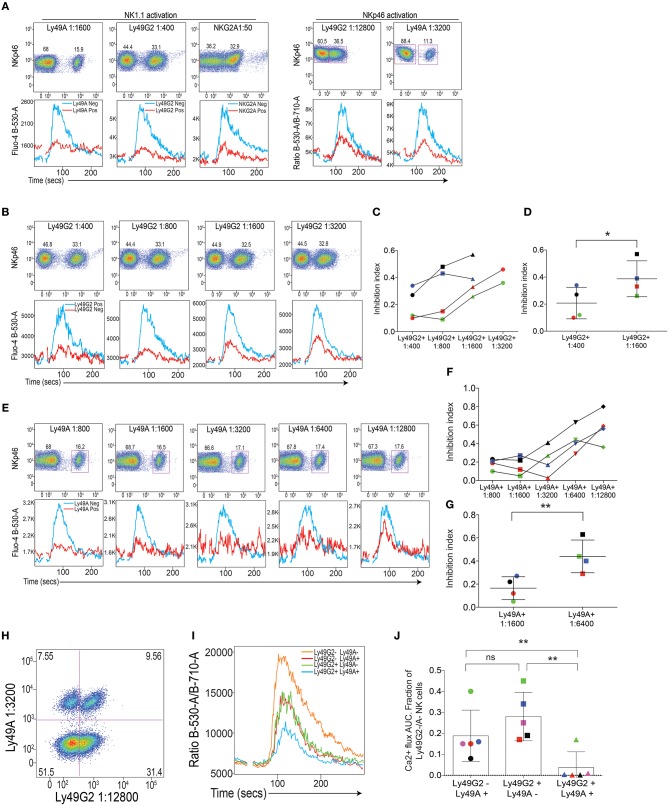
Inhibitory receptor (IR) crosslinking quantitatively downmodulates Ca2+ flux induced by activating receptor stimulation. (A) Top: Staining of Ly49A, Ly49G2 and NKG2A on mouse NK cells. Bottom: Kinetics plot of Fluo-4 fluorescence after crosslinking of NK cells coated with antibodies against NK1.1 (left) and NKp46 (right) in the presence of antibodies against inhibitory receptors Ly49A, Ly49G2 and NKG2A as indicated. Red line represents the response on the NK cell subset expressing the inhibitory receptor in question and the blue line represents the inhibitory receptor-negative subset in the same sample. Gates were set on plots in the top panel. Corresponding concentrations of the antibodies in the various dilutions are indicated in Table S1. (B) Reduction of inhibitory influence on activating signals after titration of inibitory antibody. Top: staining of Ly49G2 at various antibody dilutions. Bottom: Kinetics plot of Fluo-4 fluorescence after NK1.1 activation in the presence of various concentrations of Ly49G2. Red line represents the response on the NK cell subset expressing the inhibitory receptor in question and the blue line represents the inhibitory receptor-negative subset in the same sample. (C) The “inhibition index” (see Materials and Methods) becomes bigger following reduced concentration of inhibitory recept antibody. Data from four individual color-coded experiments. The red experiments is the one depicted in (B). (D) Statistical analysis between the 1:400 and 1:1600 groups in (C) using Student's T-test. (E–G) Same setups as in (B–D) but for Ly49A instead. (H) Double staining of Ly49A and Ly49G2 on isolated mouse NK cells. Dilutions of the antibodies was chosen so as to provide clearly detectable stainings an at the same time only partial inhibition. (I) Kinetics plot of the Fluo-4/Fura-red flourescence ratio in NK cells expressing Ly49A, Ly49G2, both receptors or none of these receptors. (J) Statistical analysis of the AUC values after baseline correction of Ca2+ flux from the three subsets expressing either one or both inhibitory receptors in I. Summary of 5 independent experiments, which are color-coded. The red experiment is shown in (I). Statistical analysis in (D,G) was performed using a two-way Student's T test and in (J) using a one-way ANOVA with Tukey's multiple comparisons test. *p < 0.05, **p < 0.01, ns, not significant.